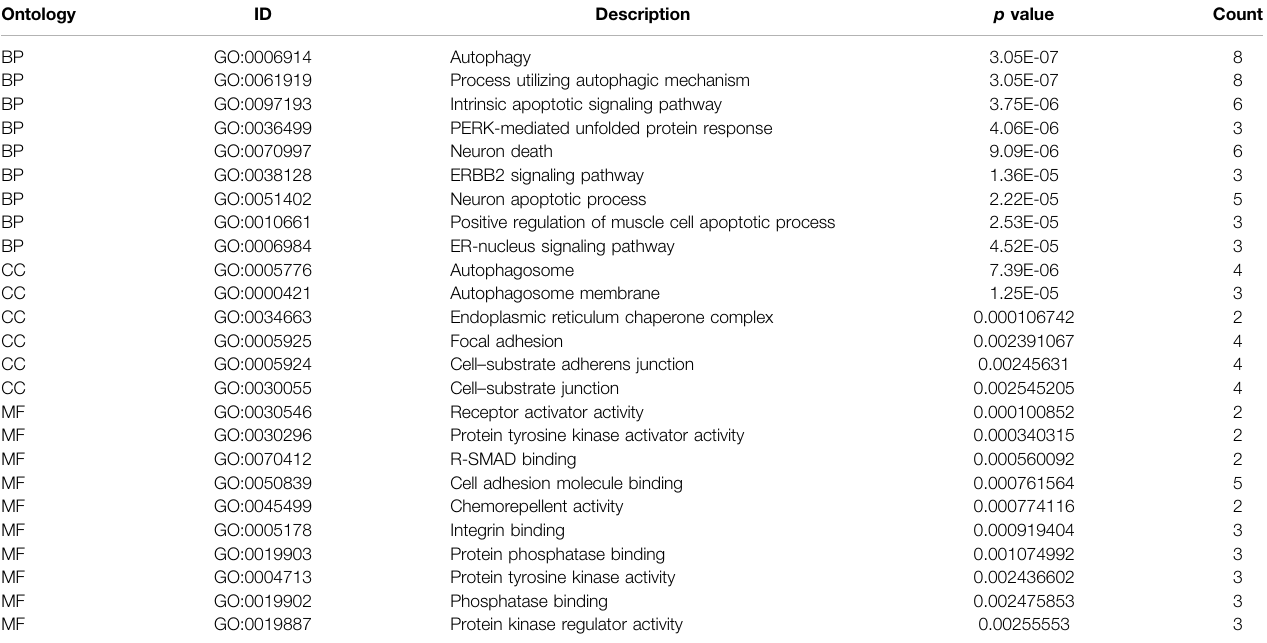
TABLE 1 | Top 25 GO terms based on 28 differentially expressed autophagy-related genes.